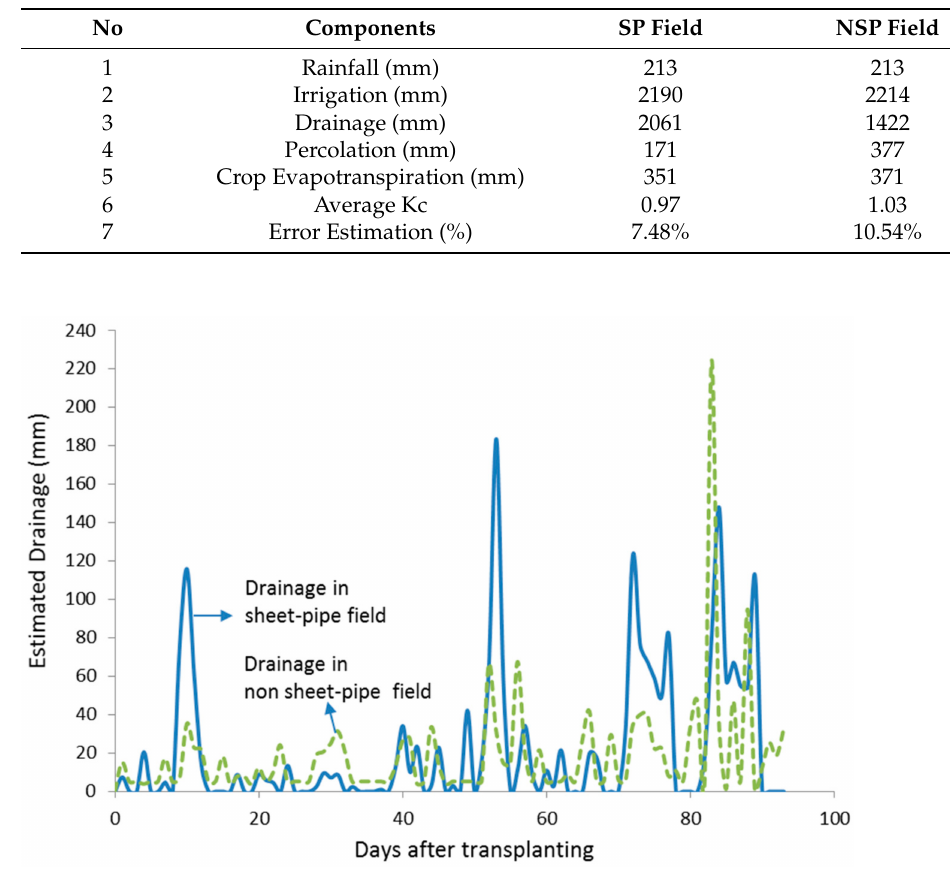
Figure 7. Drainage during the planting period in the sheet-pipe (SP) field and non sheet-pipe (NSP)